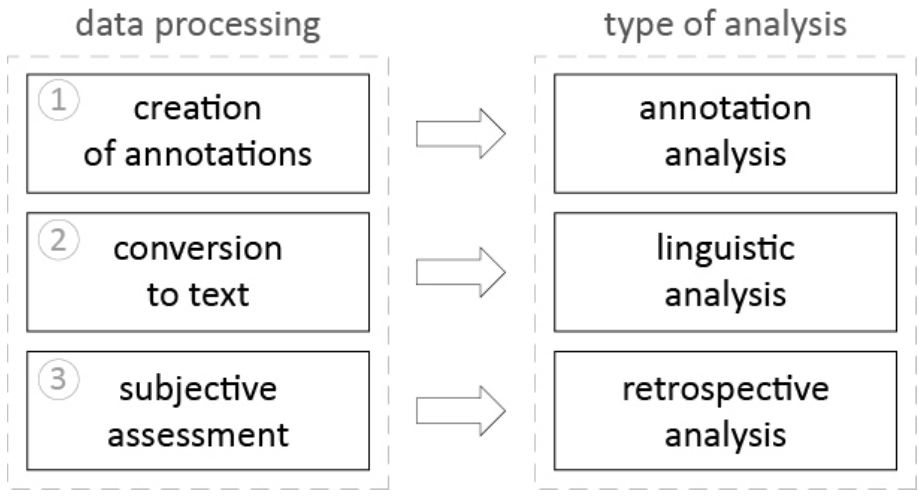
Figure 5. Possibilities for audio data processing and